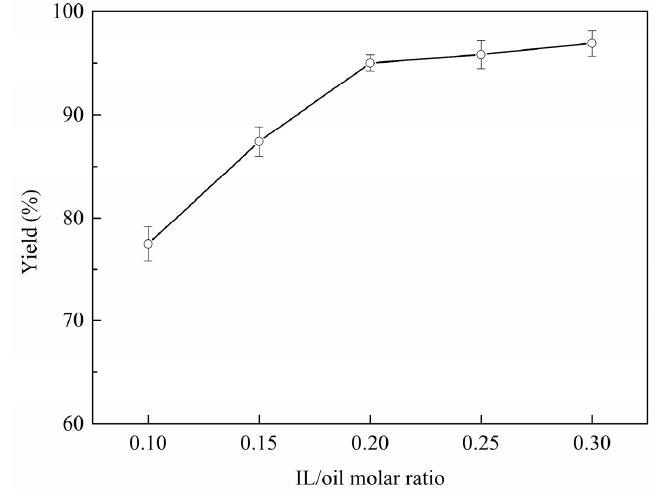
Figure 7. Effect of [HSO 3 ‐ bCPL][HSO 4 ] dosage on the transesterification at temperature of 140 °C, reaction time of 3 h, and glycerol/oil molar ratio of 9.